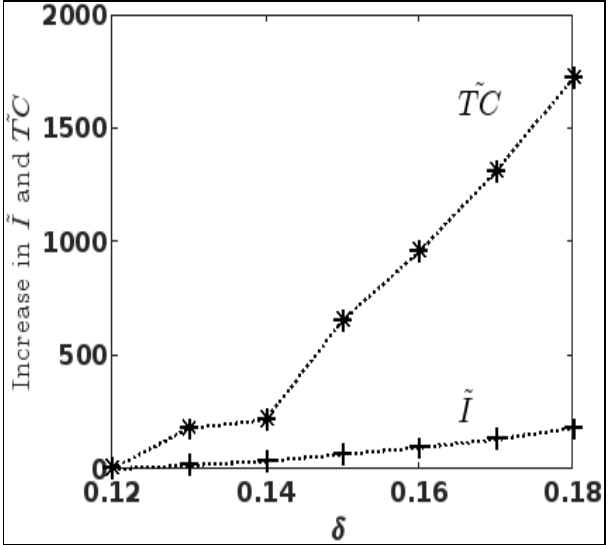
Figure 3. Effect of inflation rate on optimizing the total cost and ordering quantity.